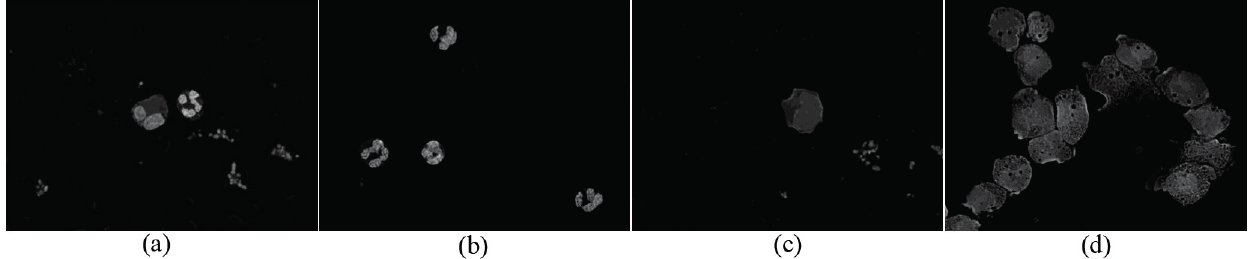
Figure 8. C component after clustering of four images in Figure 5.